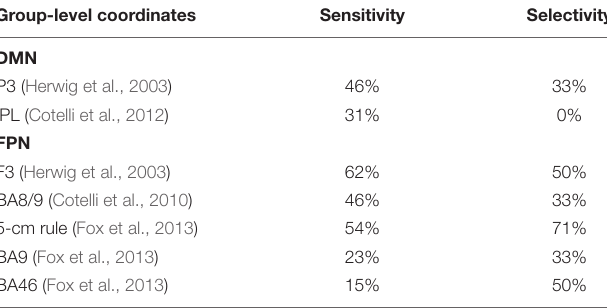
TABLE 3 | Correspondence between group-level IPL and DLPFC coordinates and individual DMN and FPN maps. Group-level coordinates Sensitivity Selectivity